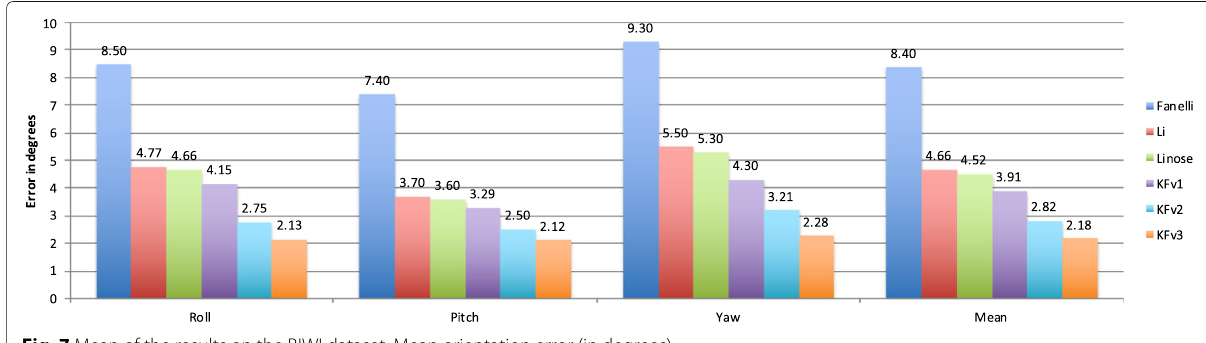
Fig. 7 Mean of the results on the BIWI dataset. Mean orientation error (in degrees)